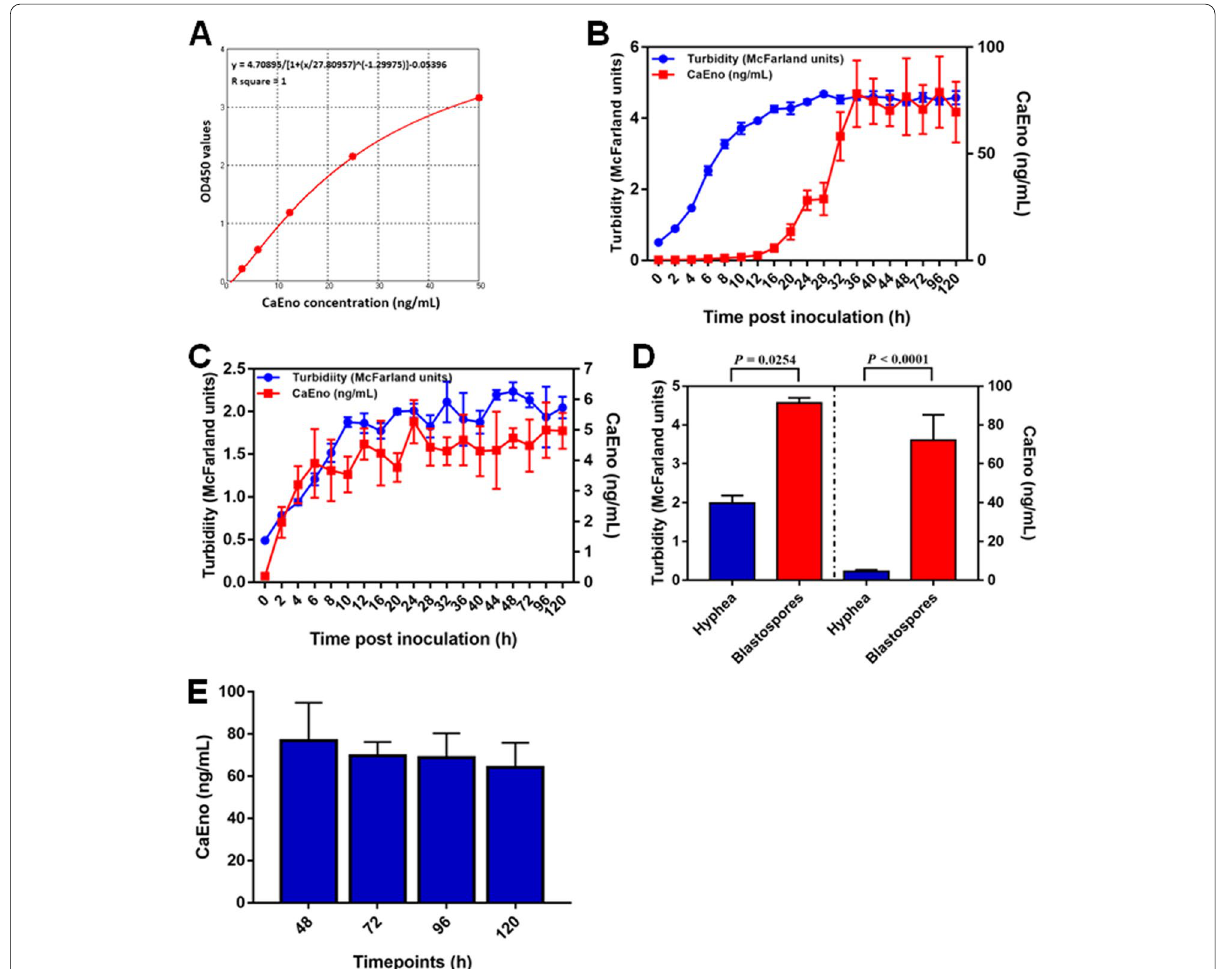
Fig. 7 Analysis of CaEno concentrations in the culture supernatants. A Calibration curve for determining CaEno by double antibody sandwich ELISA. B Growth curve of C. albicans SC5314 in YPD medium and supernatant CaEno concentration dynamic curve. C Growth curve of C. albicans SC5314 in RMPI with 10% FBS and supernatant CaEno concentration dynamic curve. D Comparison of average turbidity (left) and supernatant CaEno concentrations (right) between C. albicans blastospores and hyphea in stationary phase. E Dynamic changes of CaEno concentration in cell-free C. albicans blastospore culture supernatant when maintained under 37